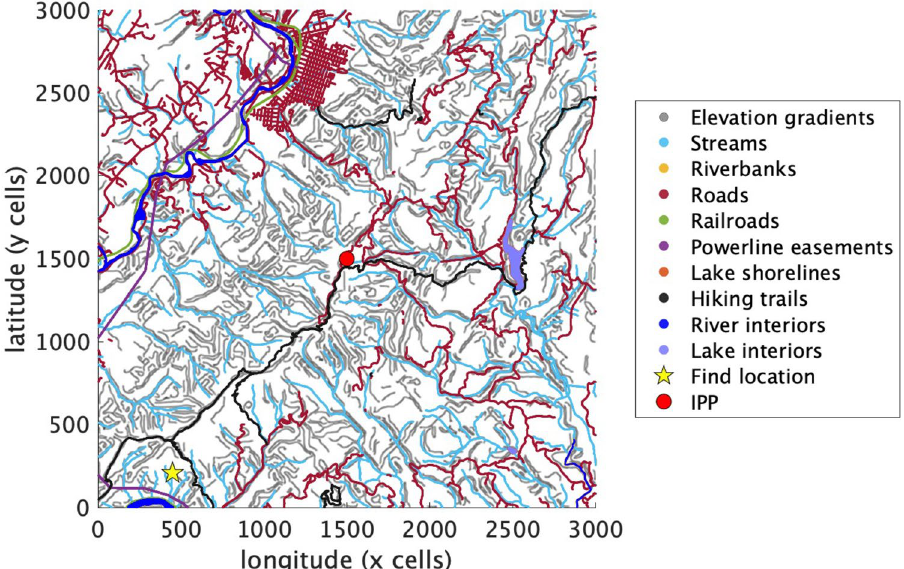
Figure 1. Example map of LP location with salient features. An example of an incident with its IPP (red circle), its corresponding find location in the lower left (yellow star), linear features (elevation gradients, streams, riverbanks, roads, railroads, powerline easements, lake shorelines, and hiking trails), and inaccessible areas (river and lake interiors). The map was generated using MATLAB 2020b and further details are included in the Supplementary